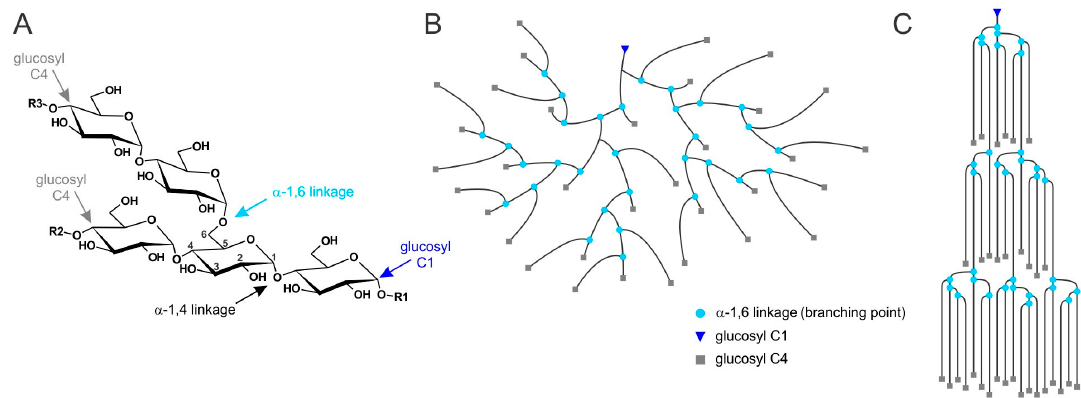
Figure 3. Branching structure of amylopectin and glycogen. ( A ) Chemical basis of a branched α -glucan. R1, glucan chain at the reducing end; R2 and R3, chains at the nonreducing ends; ( B , C ) Segments of glycogen and amylopectin, respectively. In glycogen, branching points are essentially distributed evenly; in amylopectin, they are clustered. In areas with a low abundance of branching points, double-helices form. Modified version from [20].